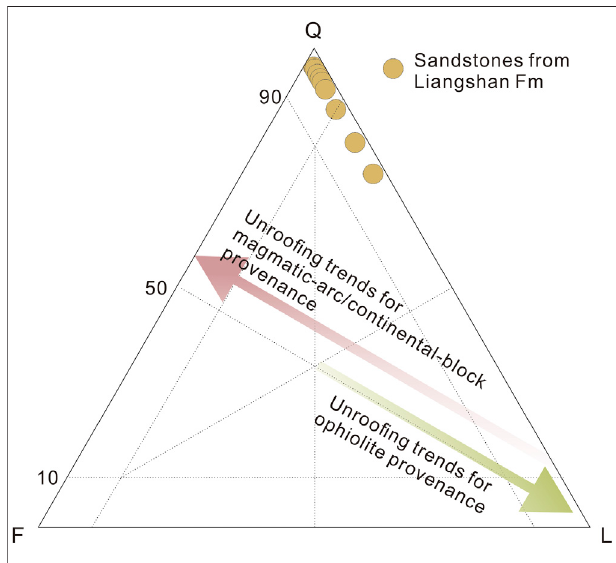
FIGURE 6 | Q-F-L (quartz – feldspar – lithic fragment) petrographic classi fi cation (Dickinson, 1970; Garzanti, 2016, 2019) of the sandstone samples from the Liangshan Formation, noting the coastal plain coarse sandstones with more lithic fragments.